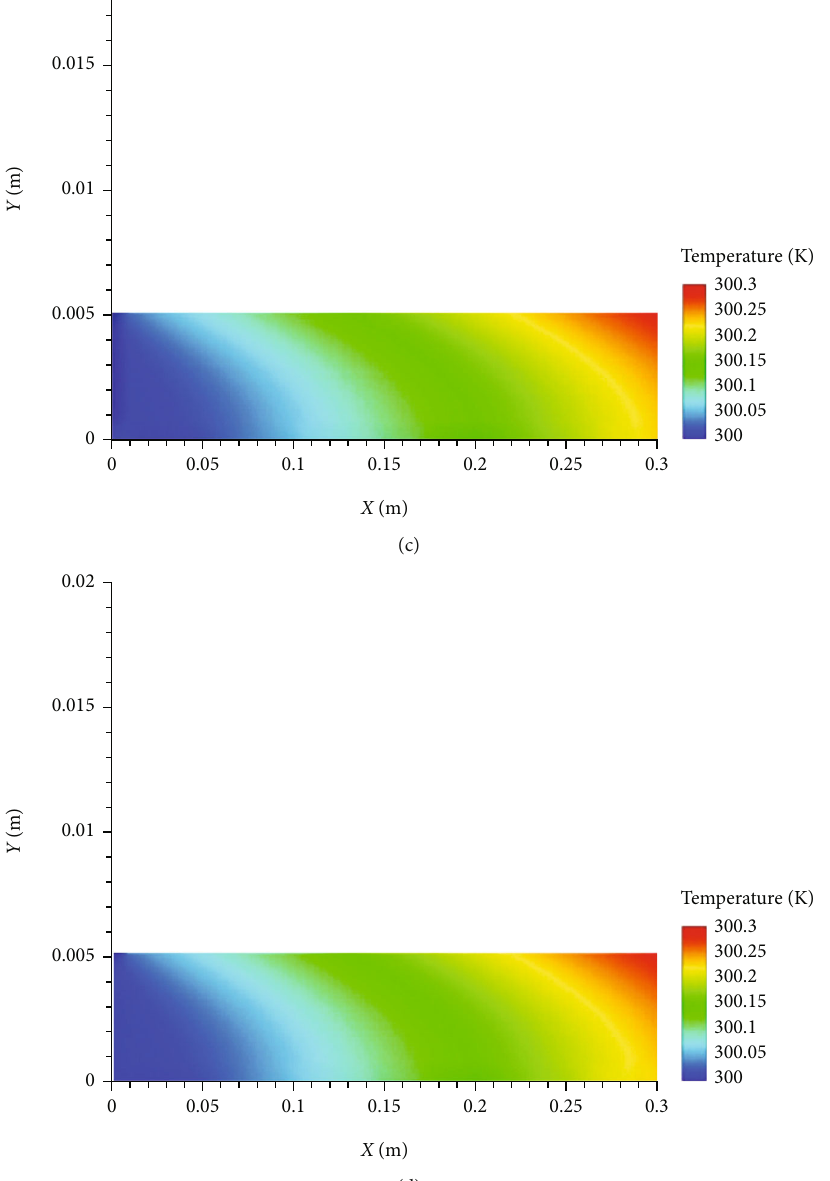
O nano fl uid ( Da = 0 : 1, Ha = 40, ψ = 0 ° ). (b) Temperature contour for 2 3 O nano fl uid ( Da = 0 : 1, Ha = 40, ψ = 90 ° 2 3